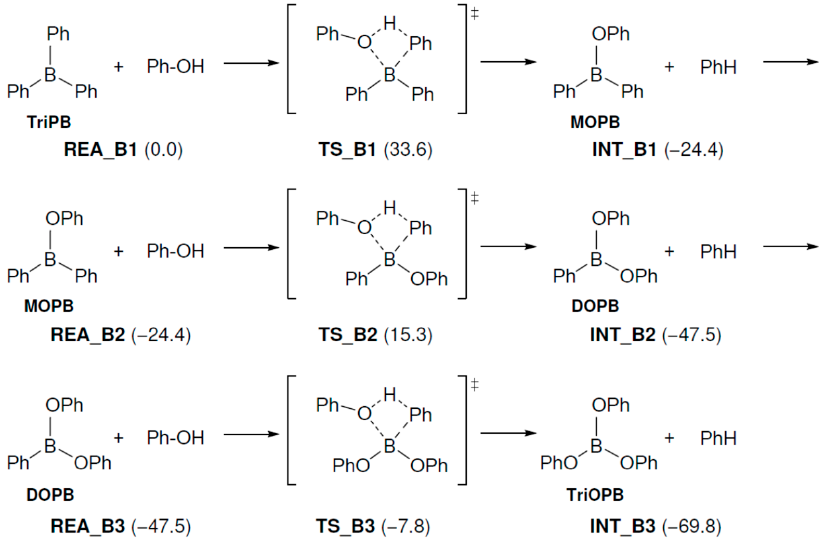
Figure 4. Geometry and free energy changes in the triphenylborate-forming reaction. The bond lengths are in Å. Relative free energies (kcal/mol) to REA_B1 are in parentheses.